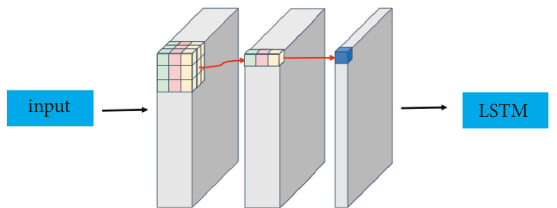
Figure 2: The workflow of CNN in extracting spatial features of music teaching